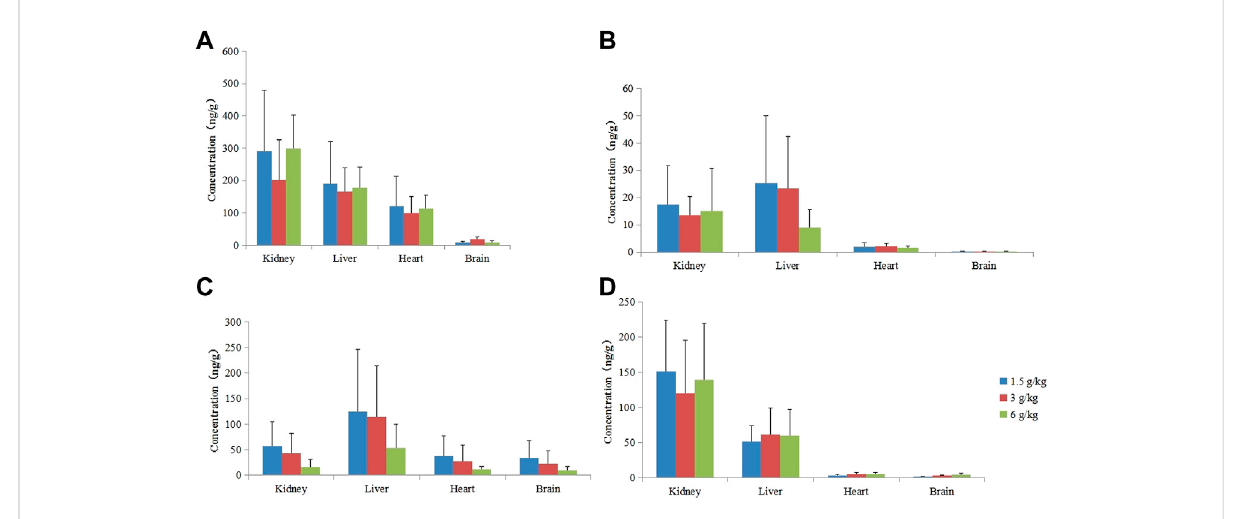
FIGURE 6 Concentration of four components in different tissues at different doses. (A) Agarotetrol; (B) isoliquiritigenin; (C) piperine; (D) ferulic